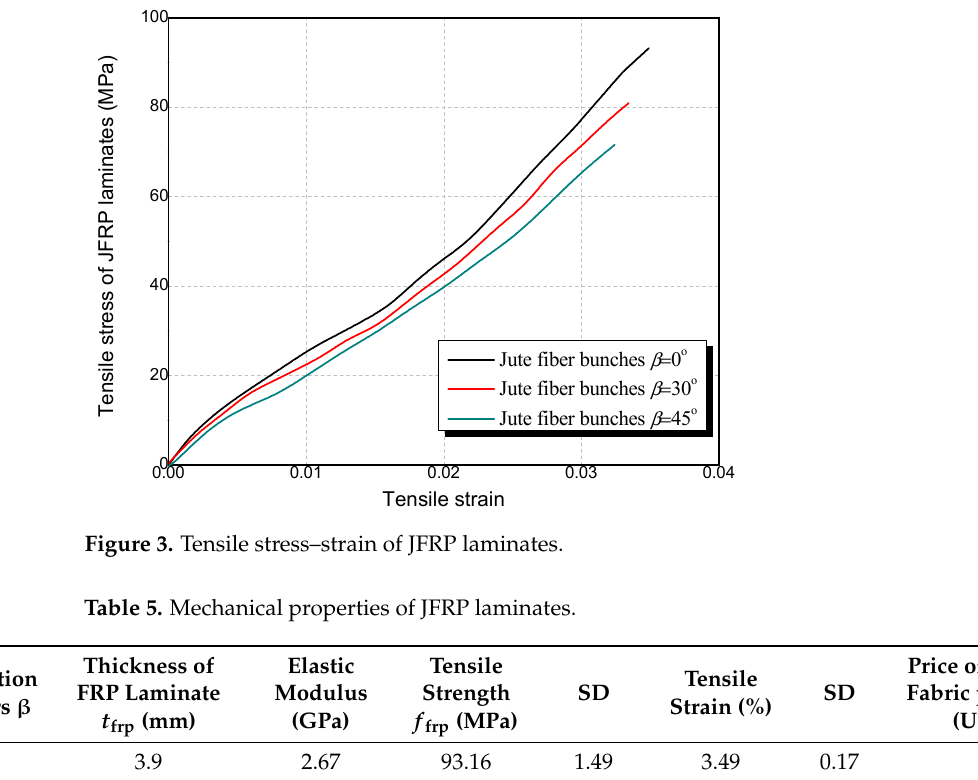
Figure 2. Details of cut jute fabric with different fiber orientations ( a ) β = 45°, ( b ) β = 30°.